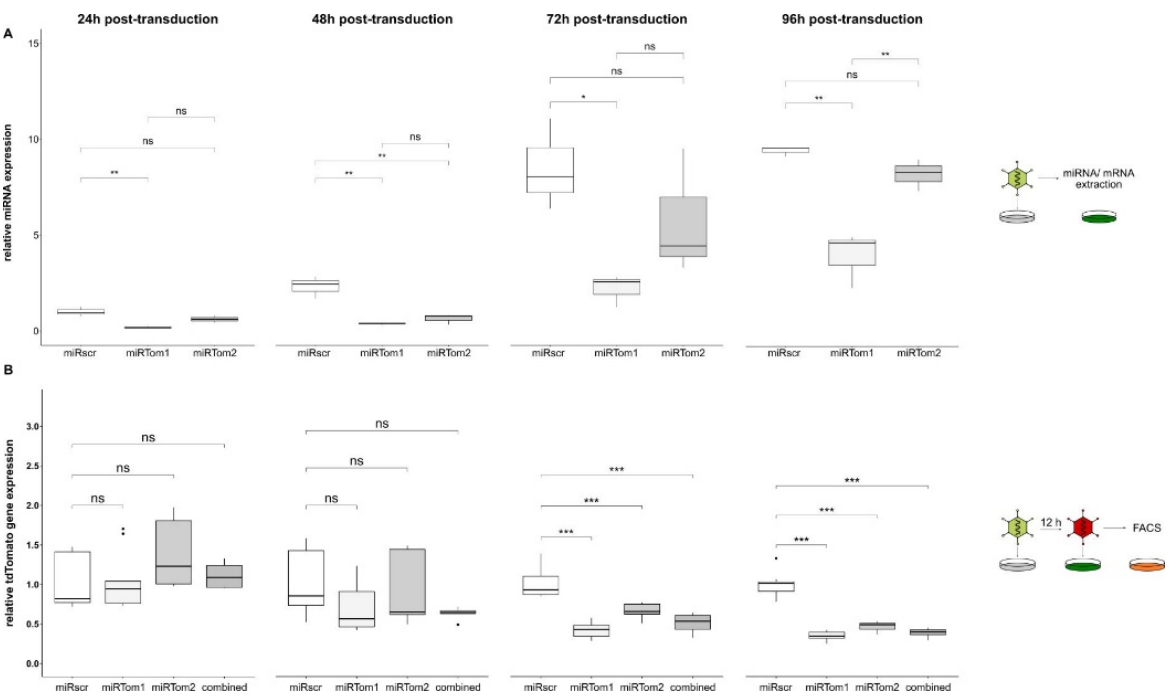
Figure 2. Ad-derived miRNAs were stably expressed for 96h and suppress target gene expression. ( A ) We monitored Ad-driven miRNA expression (MOI 500) over 96 h using quantitative PCR. Con- trol miRNA miRscr showed elevated expression levels compared to miRTom1 and miRTom2 at all time points. Further, all miRNAs seemed to accumulate in the cell over time (24 h vs. 96 h: miRscr, 9,51-fold; miRTom1, 3.99-fold; miRTom2, 8.28-fold). ( B ) A549 cells were transduced with either Ad- miRTom1, Ad-miRTom2, or both vectors in combination; Ad-miRscr served as negative control (MOI 2000). Cells were then transduced with Ad-tdTomato (MOI 500) with delay of 12 h. Target gene expression (tdTomato) was normalised to miRNA-expression (EGFP), and changes in tdTomato gene expression were calculated relative to Ad-miRscr-treated cells. Target gene expres- sion remained unaffected within the first 48 hpt (miRTom1: 0.69 ± 0.29, p = 0.083; miRTom2: 0.91 ± 0.42, p = 0.54; combined: 0.63 ± 0.07, p = 0.068), but significantly decreased 72 hpt with a reduction of 57.7% ± 9.31% for miRTom1 (miRTom1: 0.42 ± 0.09, p < 0.001; miRTom2: 0.66 ± 0.09, p < 0.001; com- bined: 0.51 ± 1.2, p < 0.001). This suppression became more distinct at 96 hpt. Overall, miRTom1 achieved a reduction of 65.9% ± 6.1% and thus proved to be most potent in target down-regulation (miRTom1: 0.34 ± 0.06, p < 0.001; miRTom2: 0.46 ± 0.06, p < 0.001; combined: 0.38 ± 0.06, p < 0.001). Significance values were calculated with Dunnett’s test. MFI, mean fluorescence intensity; hpt, hours post-transduction; ns, p > 0.05; *, p < 0.05; **, p < 0.01; ***, p < 0.001.